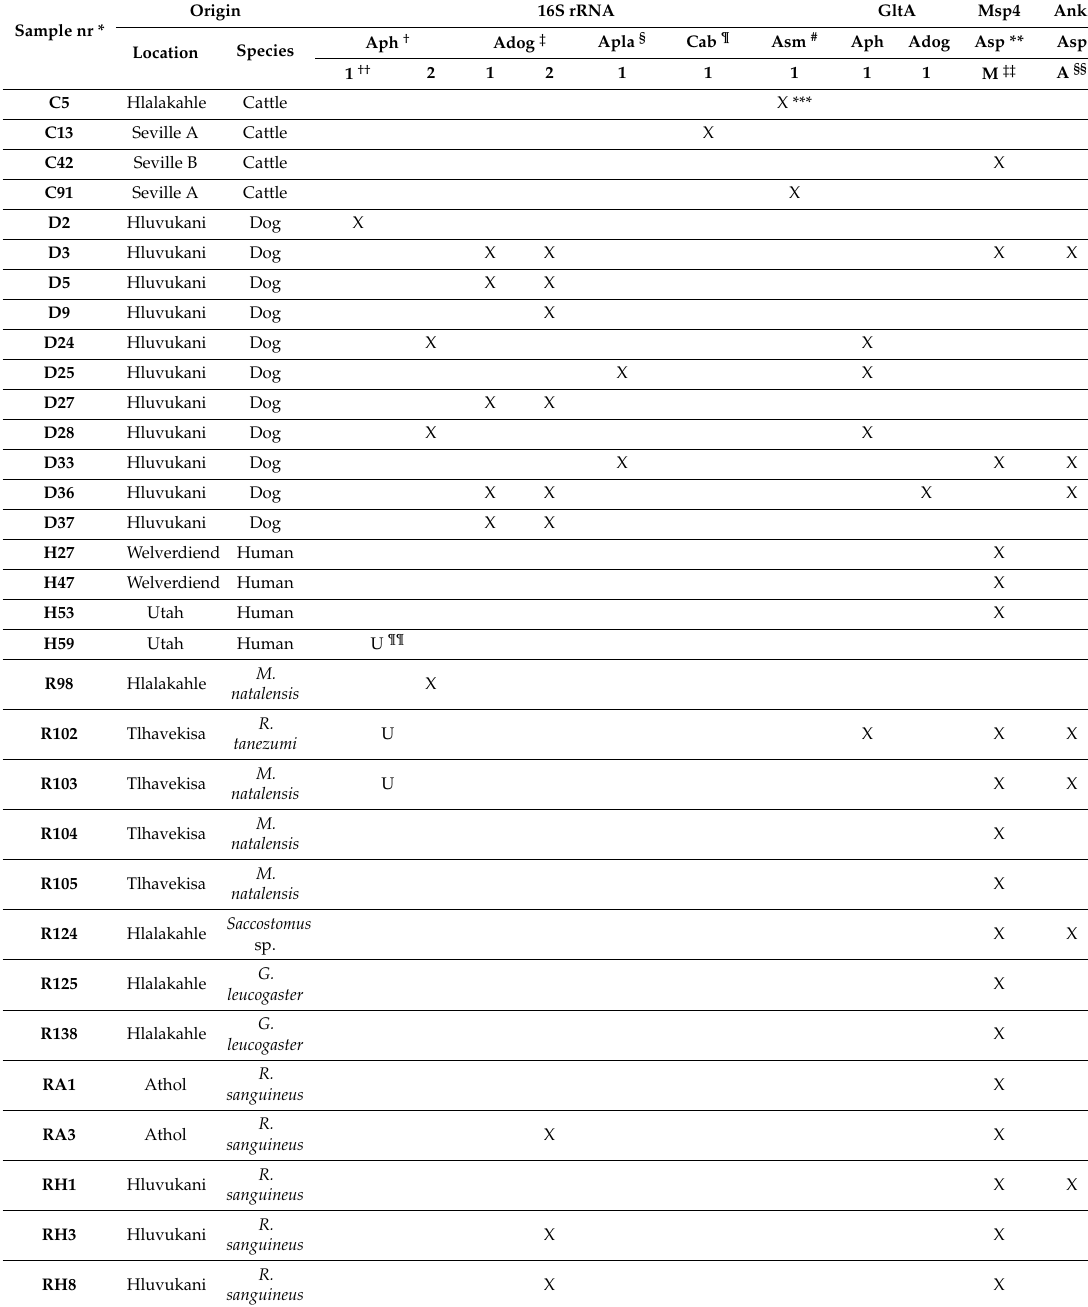
Table 3. Anaplasma species gene / protein variants detected in the Mnisi